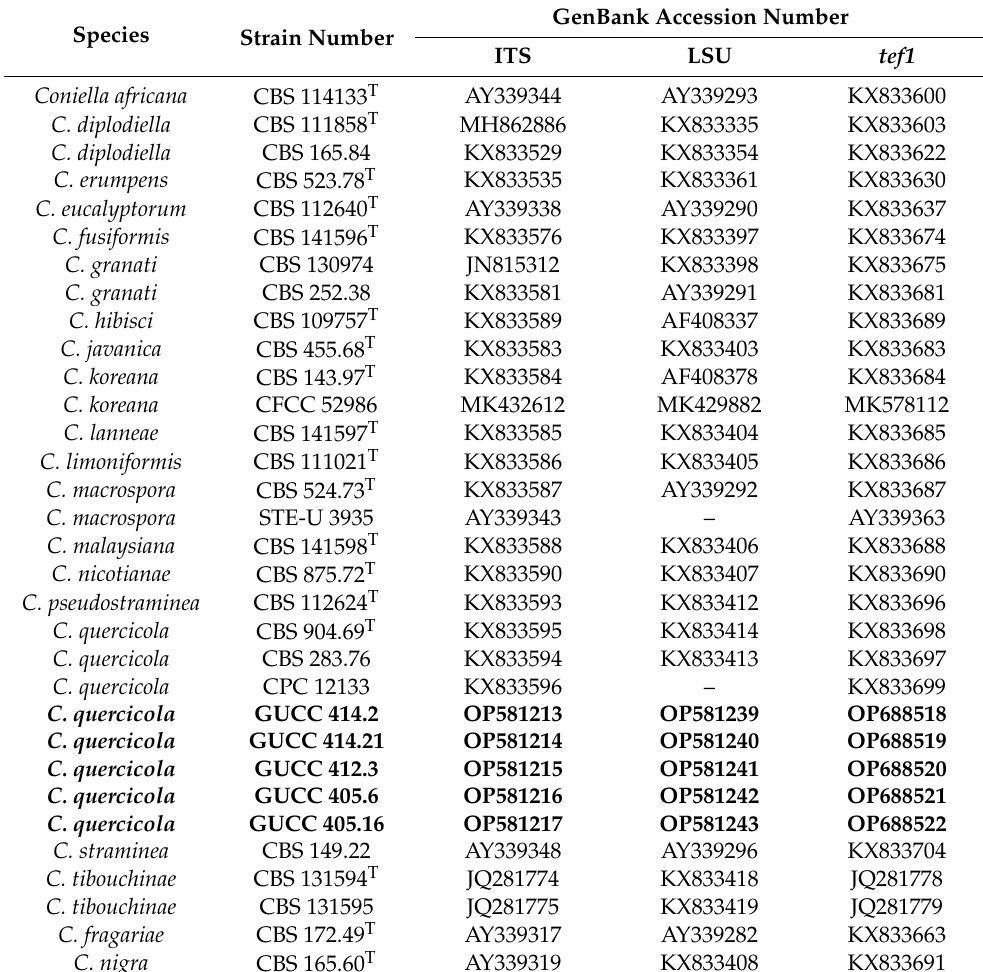
Table 5. Strains and their GenBank accession numbers used in the molecular phylogenetic analyses of Coniella . Newly generated sequences are in bold. ( T ) = ex–type